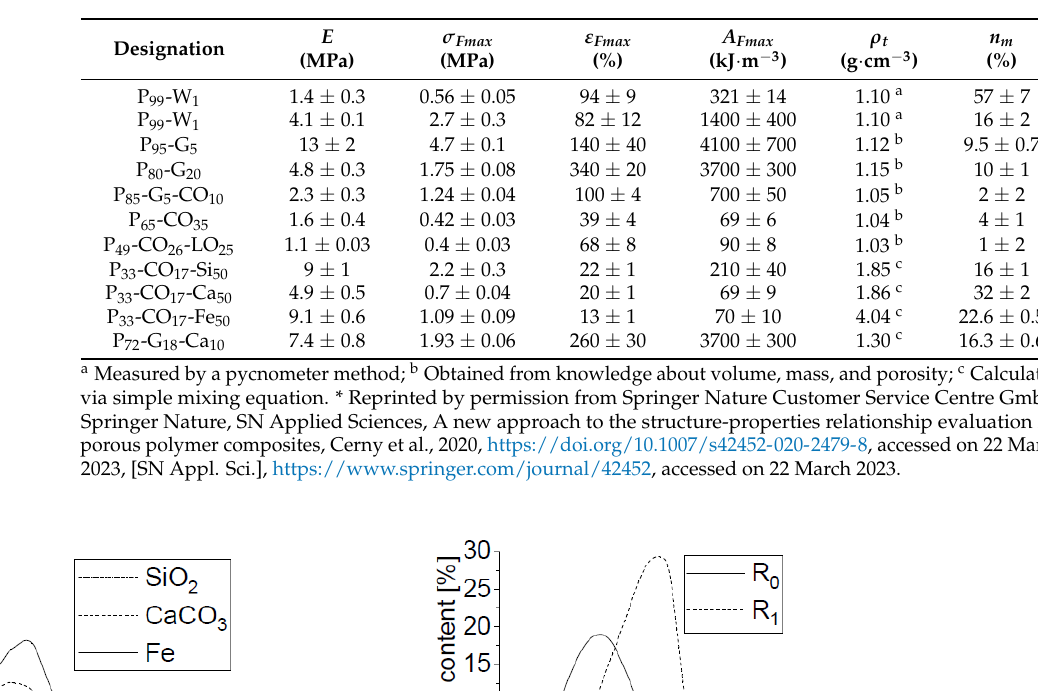
Table 2. Mechanical properties (elastic modulus E , ultimate strength σ Fmax , ultimate strain ε Fmax, and energy need corresponding to ultimate strength achievement A Fmax ), density of theoretical nonporous matrix ρ t, and whole porosity n m of PUR matrices. Table taken from previous work [33] *.